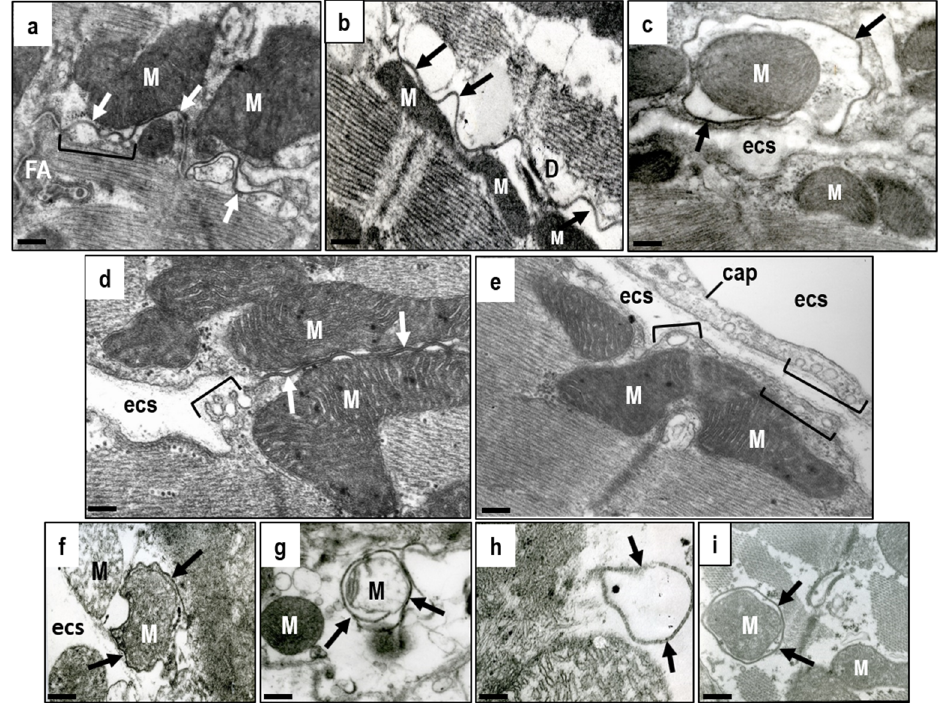
Figure 4. Electron microscopic images of rat heart cardiomyocytes illustrating the intimate rela- tionship between GJCs located at gap junction plaques (arrows) and mitochondria (M) or caveolae/rafts (brackets). This implies possible signaling crosstalk between those entities. ( a ) Long gap junction (arrows) at the intercalated disc in the vicinity of subsarcolemmal mitochondria (M); ( b , c )—Long gap junction on the lateral aspect of the cardiomyocyte touching or surrounding mitochondria; ( d )—Long gap junction touching mitochondria in the vicinity of caveolae/rafts; ( e )—Mitochondria in the vicinity of sarcolemmal caveolae/rafts and capillary rich in caveolae/rafts; ( f – i )—Myocardial ischemia and Ca 2+ overload result in cardiomyocyte injury and the loss of mito- chondrial integrity, whereby there is a close relationship between gap junction profile and mito- chondria even in those conditions. This suggests mutual GJCs, HCs and Panx1 channels communi- cation. Abbreviations: ecs—extracellular space; FA—adhesive fascia adherent junction; D—adhe- sive junction-desmosome, cap—capillary, scale bar—0.1 micrometer. Tribulova, unpublished rep- resentative electron micrographs.